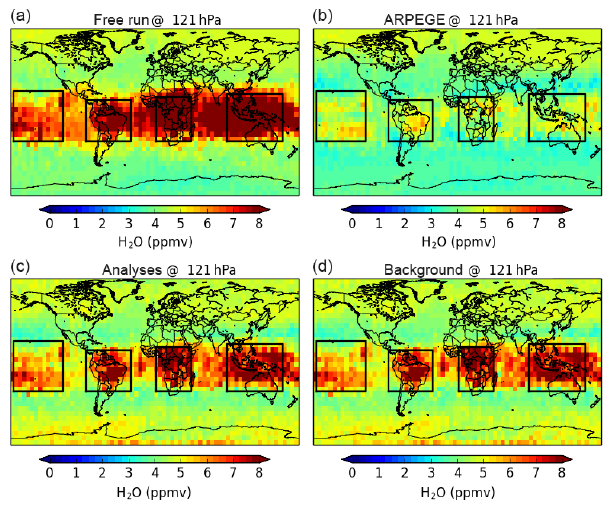
Figure 13. Monthly averaged H 2 O fields at 121hPa in January 2012 in the MIPAS observation space (in time and space coinci- dence with MIPAS observations) from the free run (MOCAGE, a ), ARPEGE (b) , MLS analyses (assimilation, c ) and the back- ground (d) .